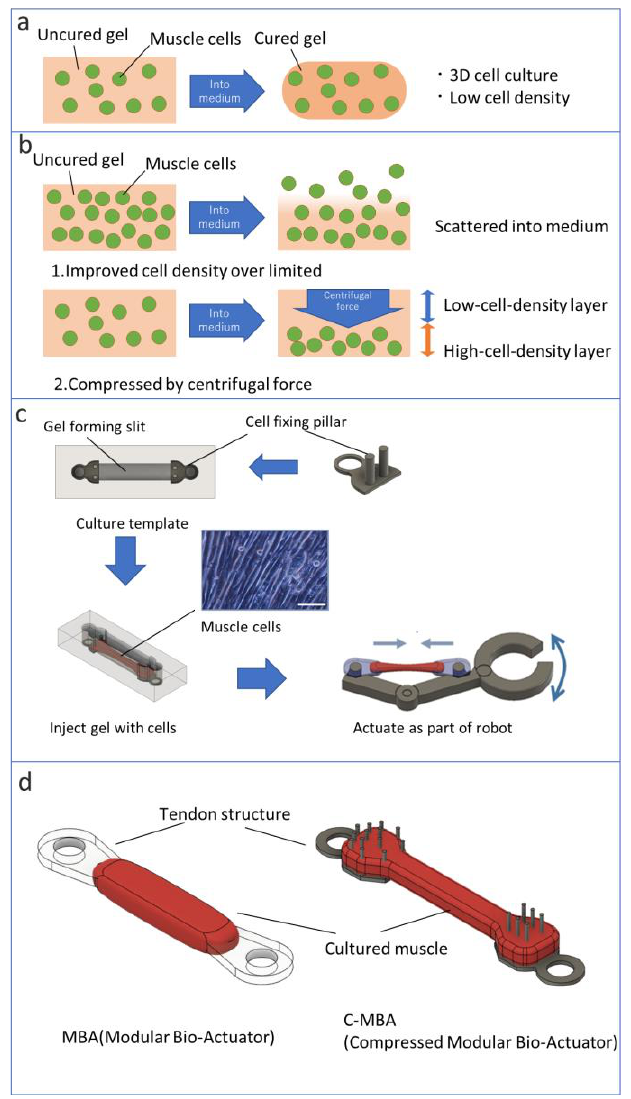
Figure 1. Concept of C-MBA: ( a ) conventional method of fabrication of 3D tissue, ( b ) concepts of centrifugal compressed cell assembling method, ( c ) overview of molding gels to create bioactuators (scale bar: 100 μm) , ( d ) overviews of MBA and C-MBA.